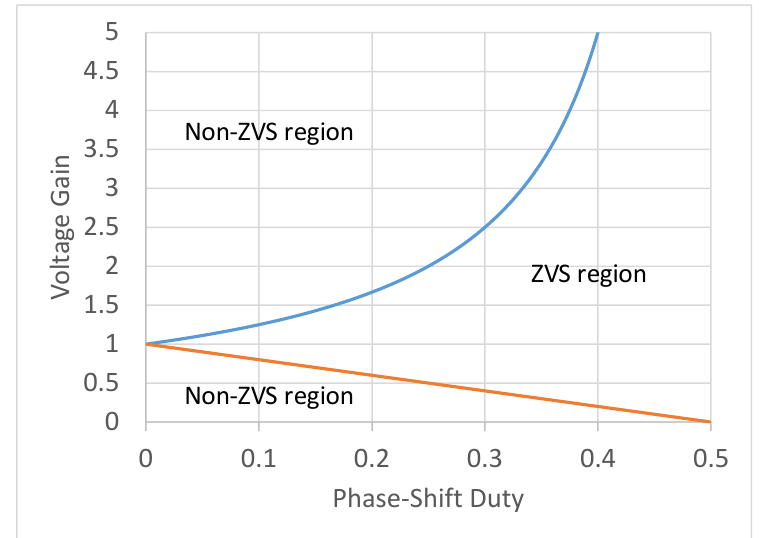
Figure 6. ZVS region of the HBDAB converters.